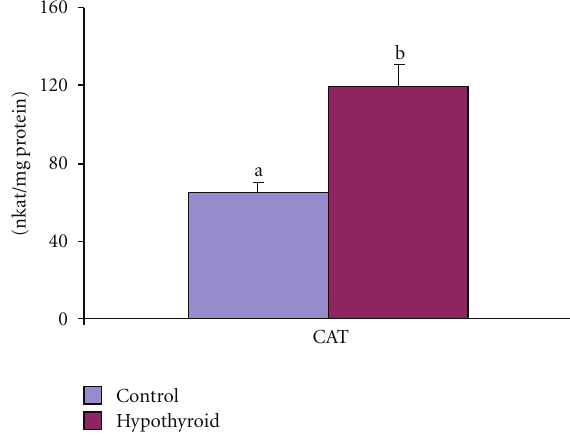
Figure 6: E ff ect of neonatal PTU treatment on catalase activity (CAT; nkat/mg protein) in postmitochondrial fraction (PMF) of testes of rats. Data are expressed as mean ± S.D. of 5 observations and subjected to unpaired Student’s t -test. Statistical significance was accepted at P < 0 . 05. Control and hypothyroid groups were found to di ff er significantly at P < 0 . 05 as represented by super- scripts of di ff erent letters. Control (Group-I): 30-day-old control rats; hypothyroid (Group-II): 30-day-old rats with PTU treatment from day 1 postpartum to day 30